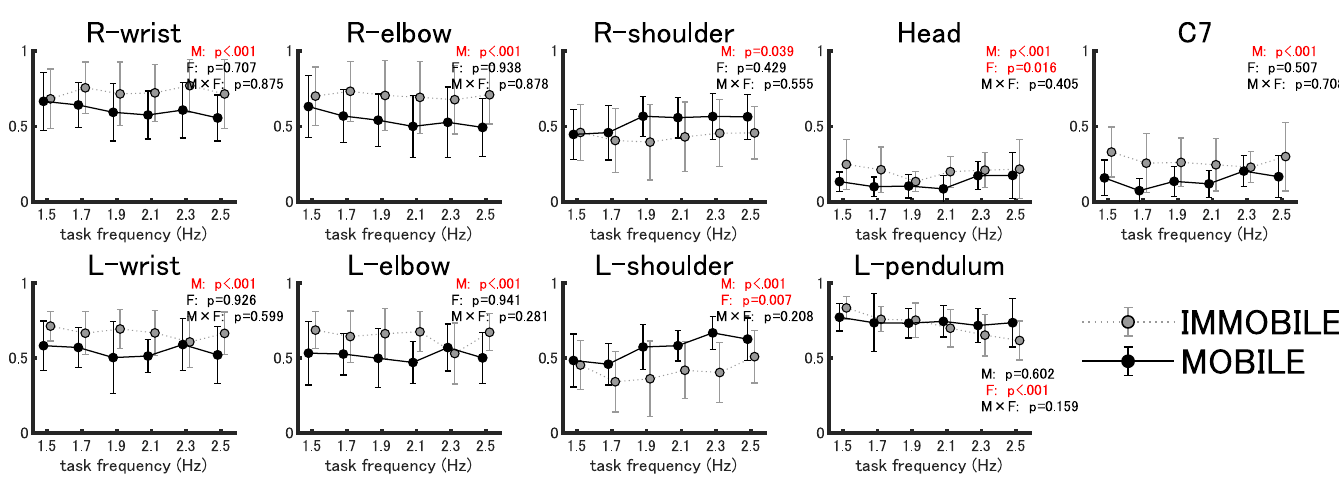
Fig 5. Motion similarity between the pendulum and body parts (anti-phase) ( N =18). Fig 5 represent the same information as Fig 4, except that the data are for anti- phase.